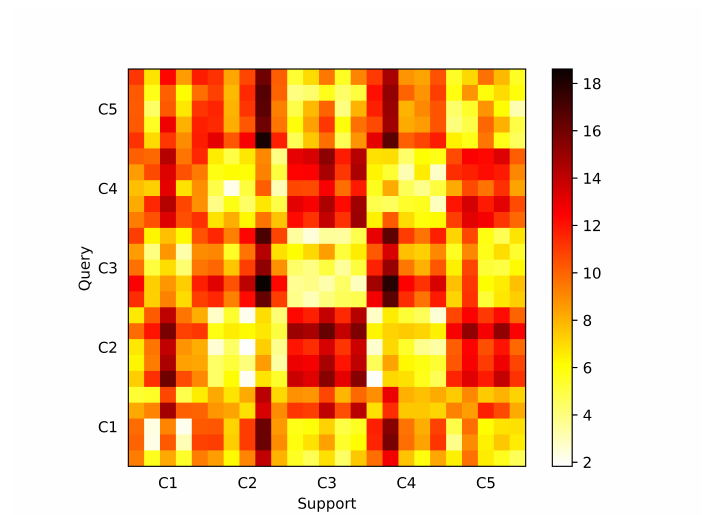
Figure 9. Visualization on DBLP (learned node